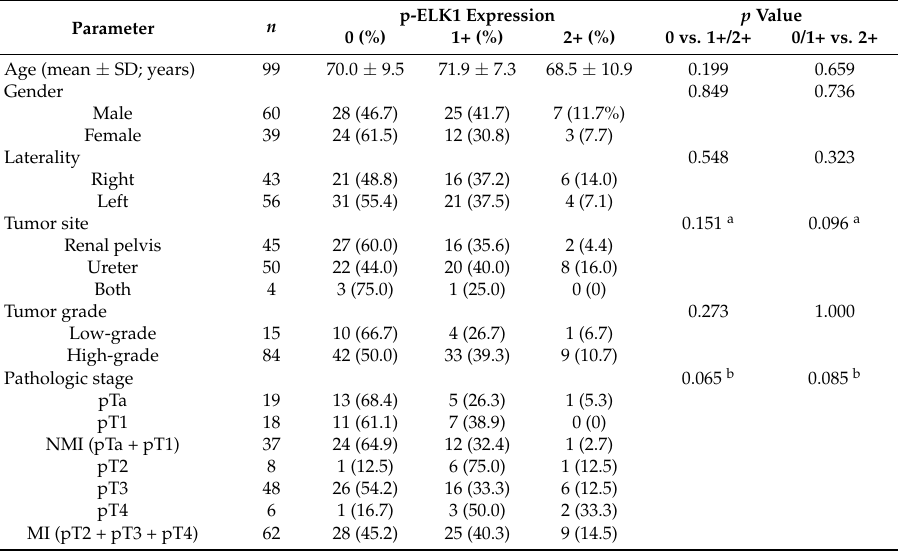
Table 2. Correlations between p-ELK1 expression and clinicopathological profile of the patients.